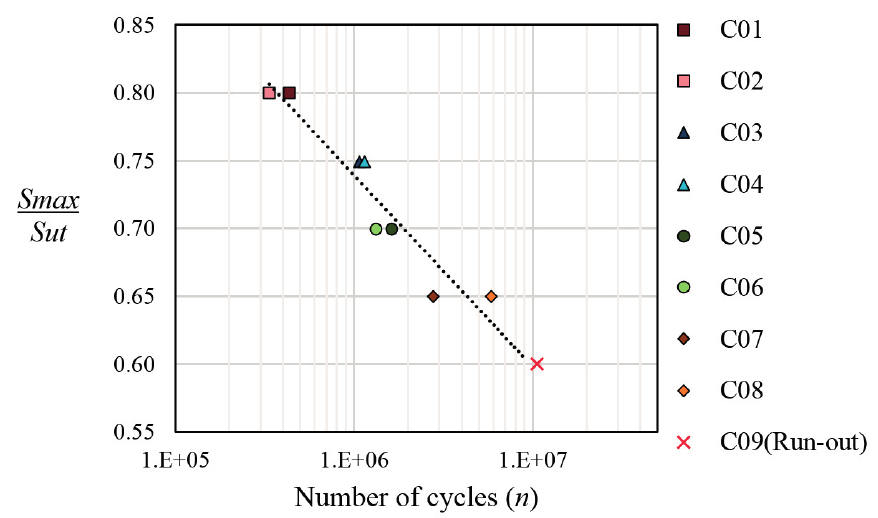
Figure 5. Gassner curve in semi-log graphic, for the coupons cycled with the FALSTAFF load sequence at different levels of maximum peak load.